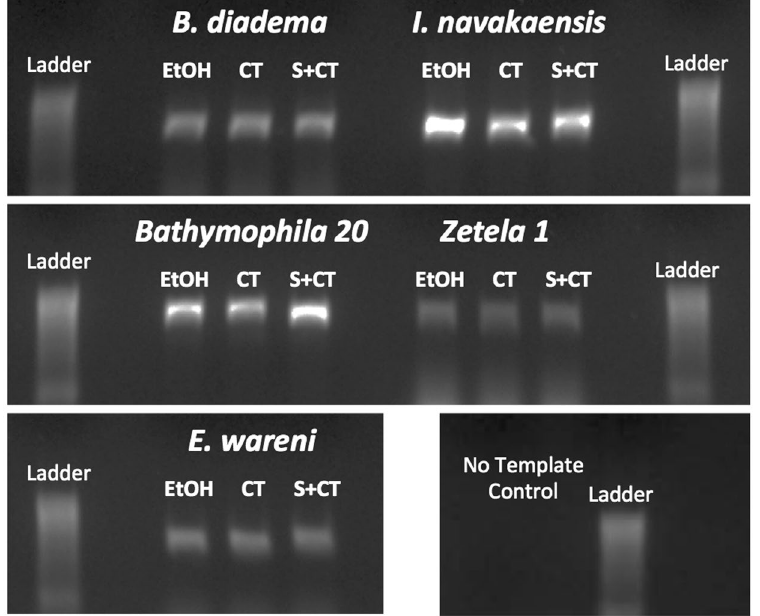
Figure 4. Staining and scanning procedures have no impact on DNA quality. Gel image from PCR, showing no difference in band size of PCR amplicons from DNA extracted from untreated and treatment samples. Tissue subsamples from the same specimen were taken before staining and scanning (‘EtOH’), after scanning but without staining (‘CT’) and after both staining and scanning (‘S + CT’). Raw metrics for DNA quantity and quality and best BLASTn hits of sequences are available in Supplementary Data 2. Gel images in this figure have been cropped from different parts of the same gel. An unedited version of the same gel is available in Supplementary Data